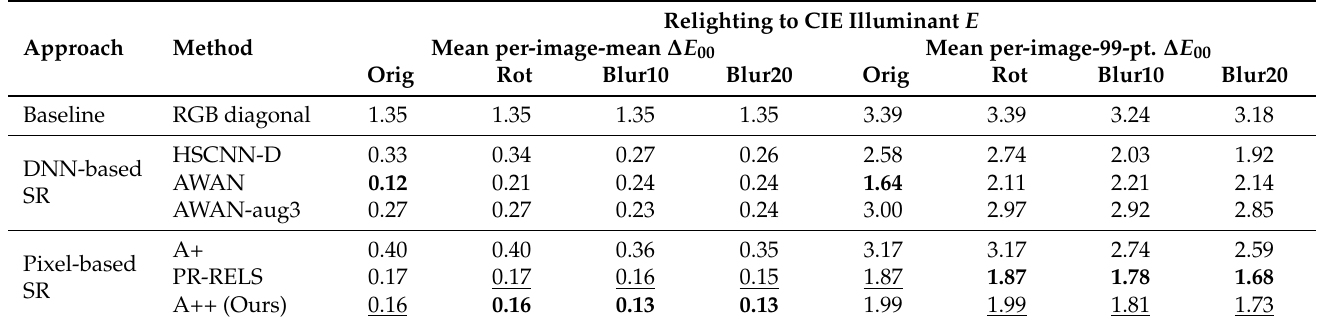
Table 7. The CIE Illuminant E relighting (the “white balancing”) results. The mean results of per- image mean and 99-percentile ∆ E 00 are presented. The best methods in each experiment are marked in bold font, and the second bests are